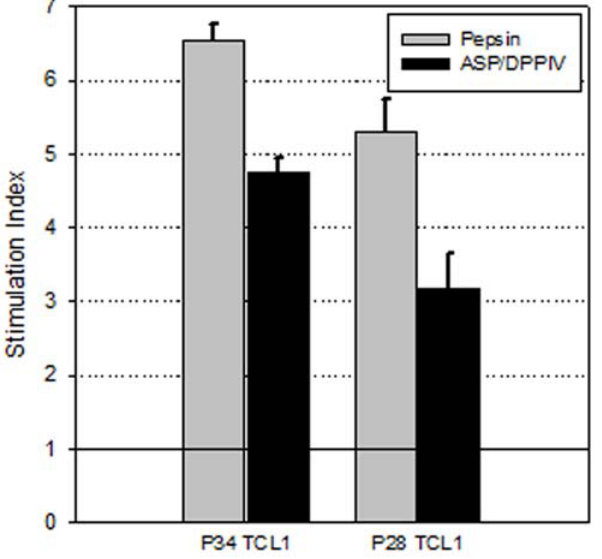
Figure 9. Stimulation of T-cell lines derived from biopsies of celiac sprue patients with gluten digested by aspergillopepsin (ASP) and dipeptidyl peptidase IV (DPPIV). Whole gluten powder (15 mg/ml) mixed with casein (50 mg/ml) was incubated with either 0.6 mg/ml pepsin or 0.35 mg/ml ASP and 0.7 mg/ml DPPIV. The digestions were initiated in 0.03 M HCl and 3 mg/ml CaCO 3 , and every 5 min additional HCl was added. After digestion for 60 min at 37 u C, the samples were further treated with 0.375 mg/ml trypsin and 0.375 mg/ ml chymotrypsin for 30 min at pH 6.0. The immunotoxic peptide content in the water-soluble fraction of the digests was measured by a T-cell proliferation assay. A stimulation index of 1 indicates background levels of T-cell proliferation and is denoted with a horizontal line. The name of the individual T-cell lines is indicated in the graph.